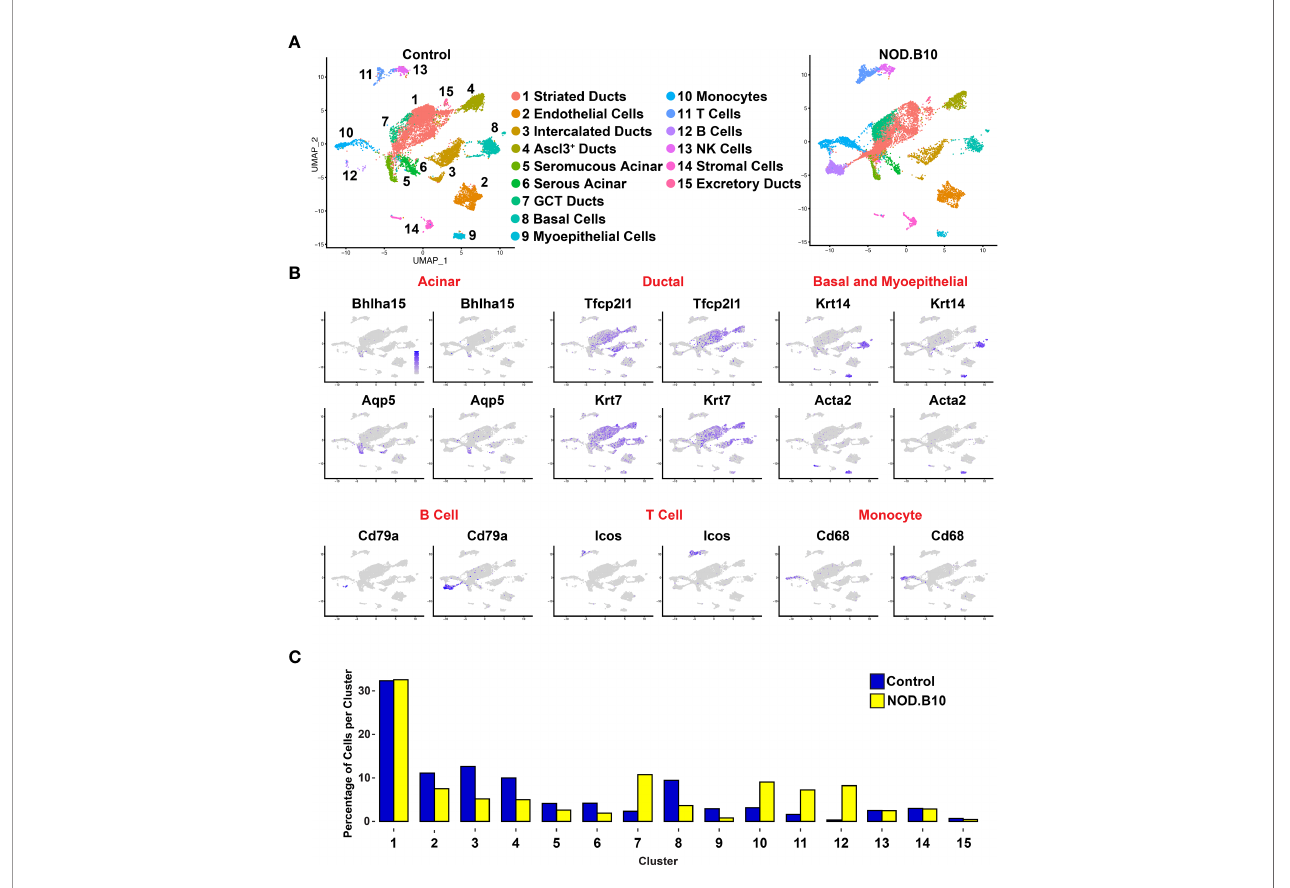
FIGURE 4 | Single-cell RNA-sequencing Reveals Alterations in Cellular Heterogeneity in Mouse pSS SMGs. (A) Uniform manifold approximation and projection (UMAP) of control and NOD.B10 mouse SMGs. Cell cluster identities are also shown. (B) Feature plots demonstrate the expression of known acinar, ductal, basal and myoepithelial and immune genes. (C) Bar graph shows the proportion of cells per